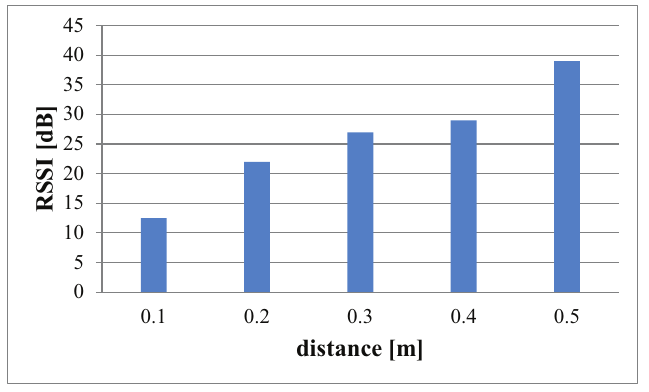
Figure 4. Estimating the path loss exponent underwater environment.